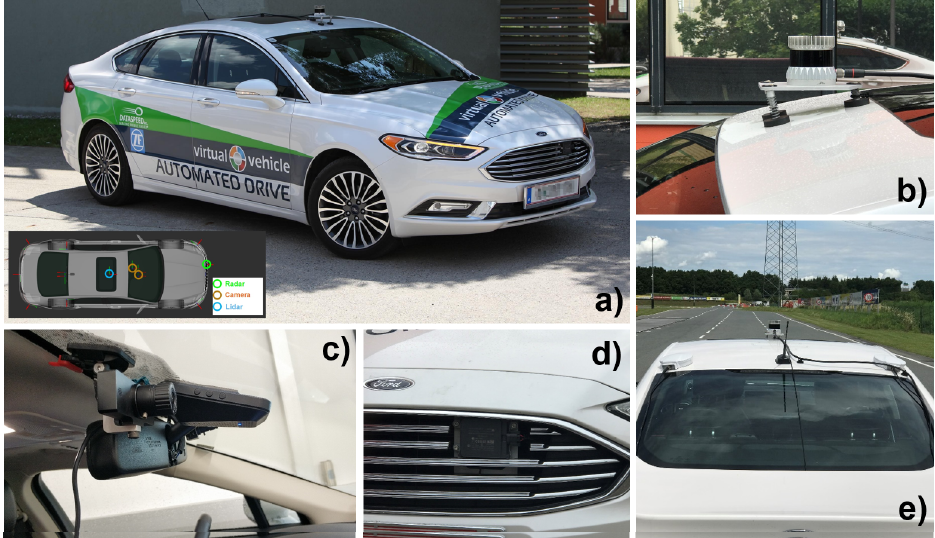
Figure 12. The PVLSA demonstrator vehicle ( a ) with its perception sensor equipment including LIDAR ( b ); RGB camera ( c ); intelligent camera ( c ), RADAR ( d ), and dual-antenna GPS with RTK ( e ).